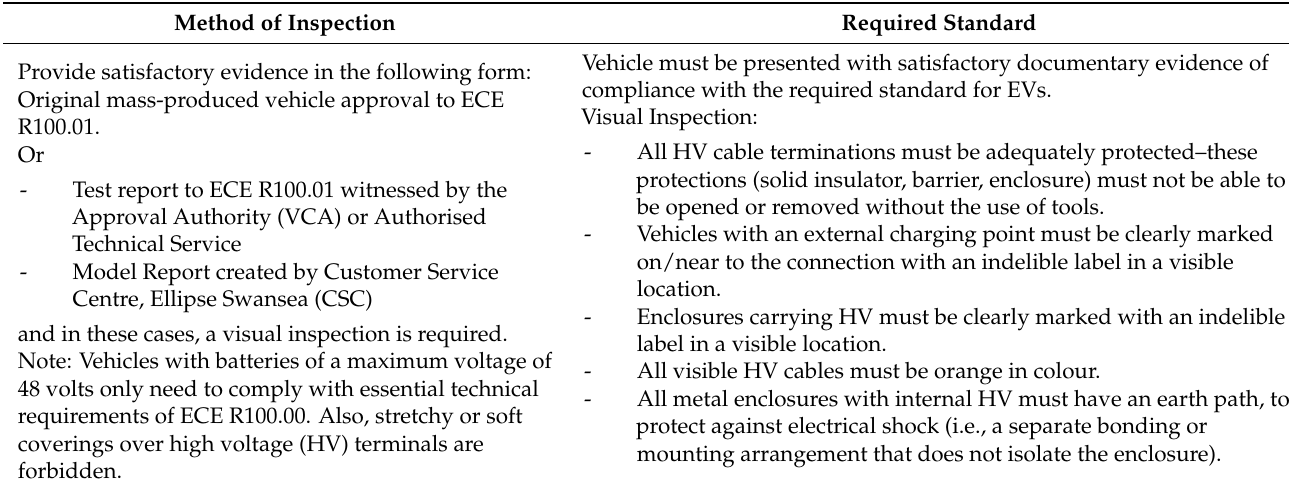
Table 2. IVA details for electric and hybrid passenger vehicles (M1)